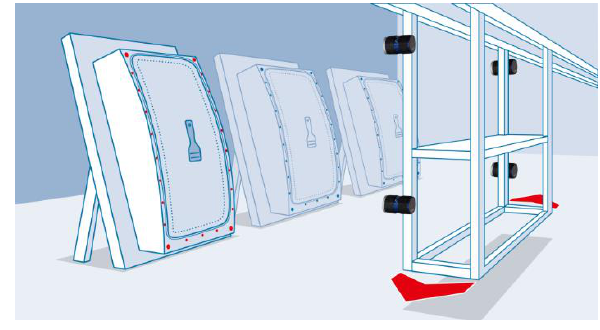
application software